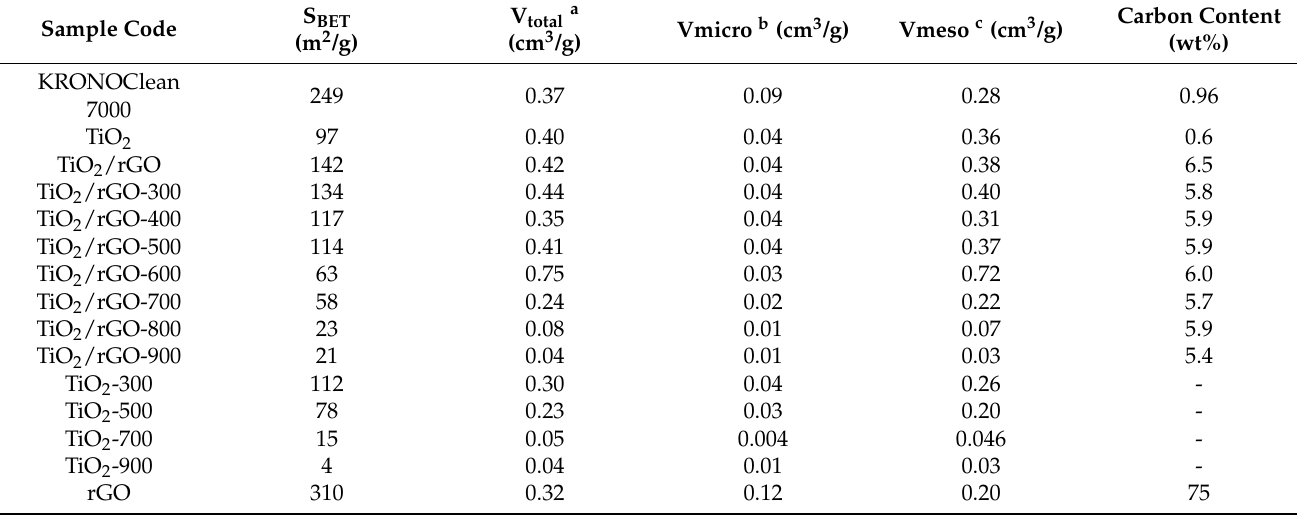
Table 2. Specific surface area and pore size distribution of studied reference, control, and prepared photocatalysts. Sample Code